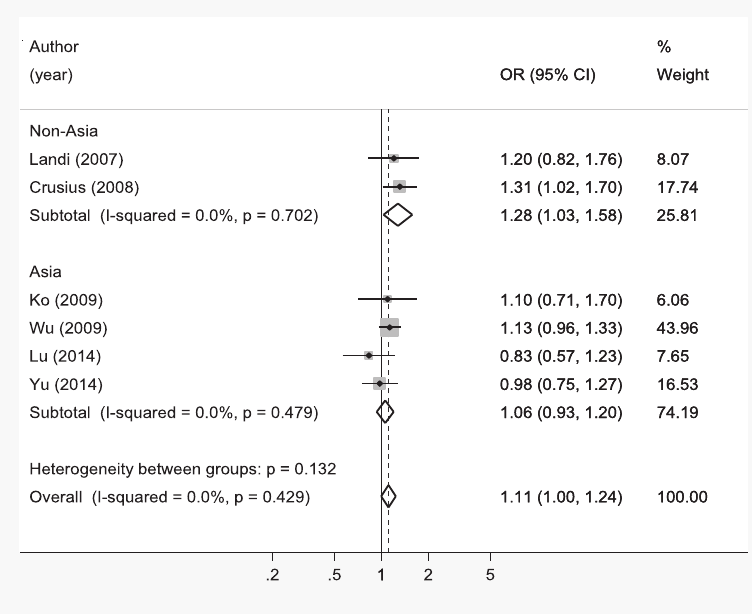
Fig. 3. Forest plot of gastrointestinal cancer risk associated with IL4 rs2070874 (T allele vs. C allele), strati fi ed by geographic location. CI, con fi dence interval; OR, odds